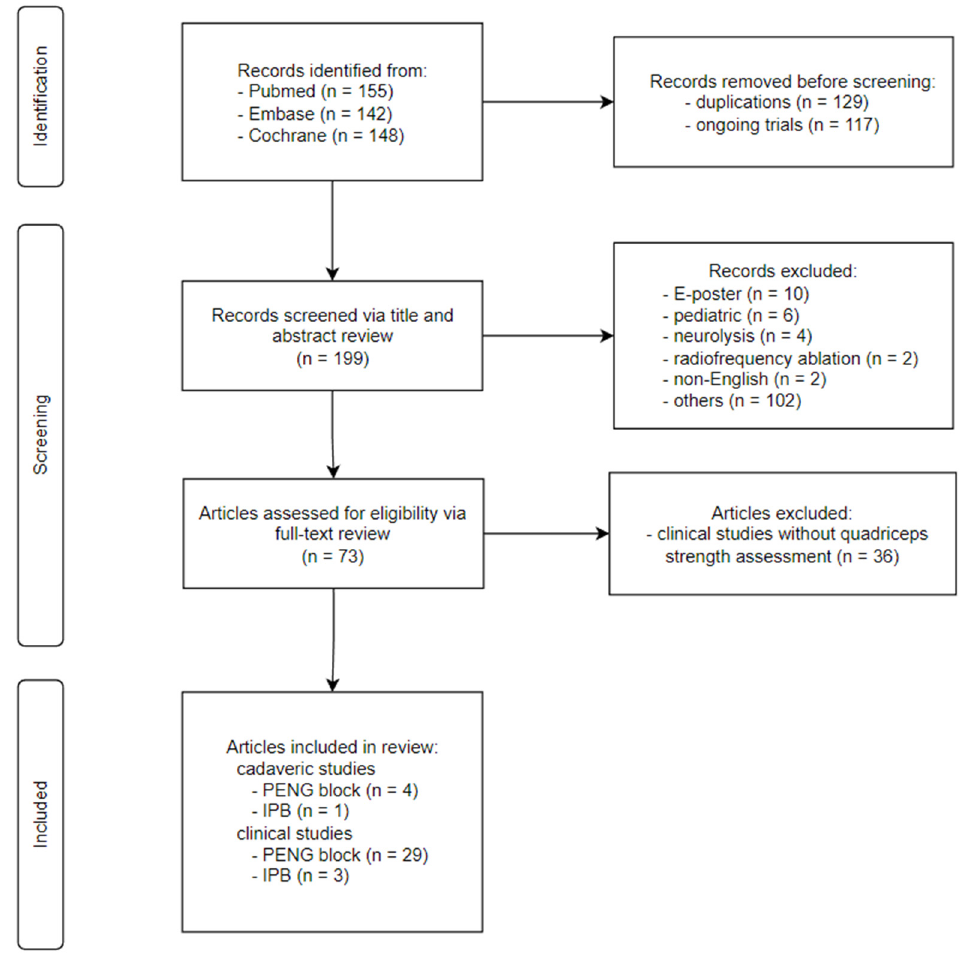
Figure 3. Flowchart for the selection of studies for the current review. IPB: iliopsoas plane block; PENG: pericapsular nerve group.